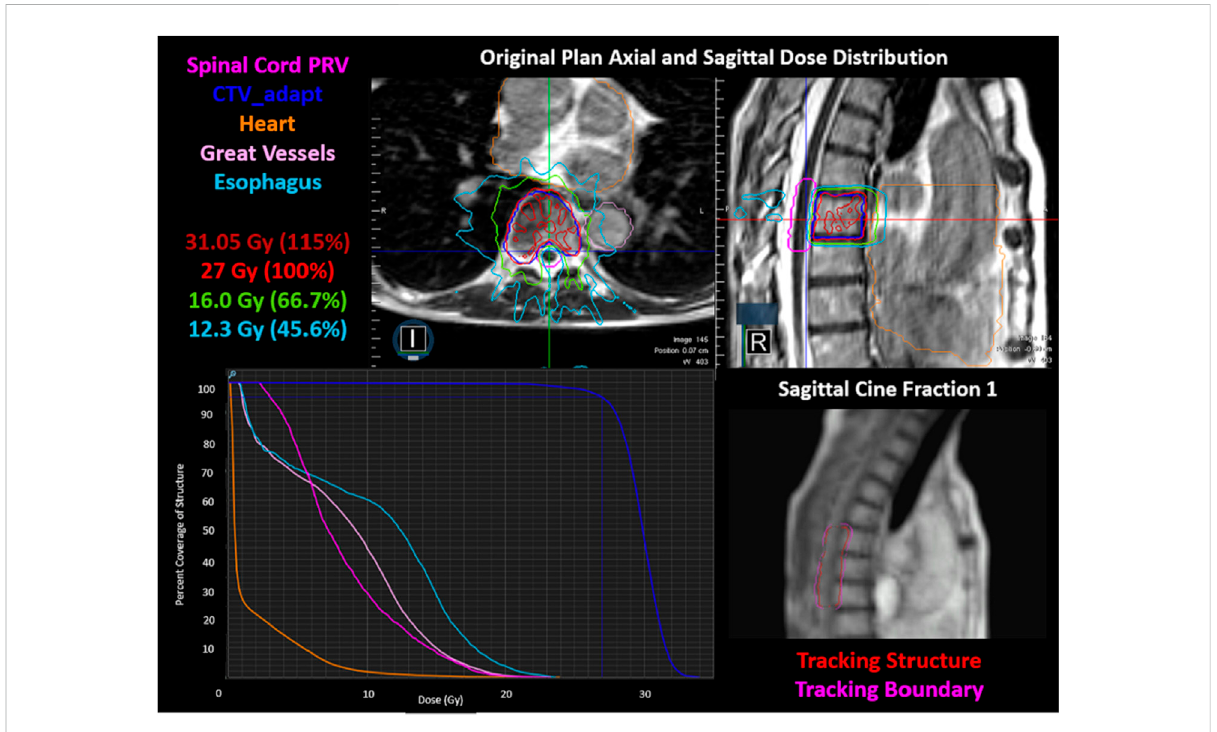
FIGURE 5 The original plan axial and sagittal dose distributions, showing the isodose lines, target structure, and organs at risk. The corresponding DVH is showninthebottomleft.Thecineimagequalityforfractiononeisshowninthebottomright,includingthetrackingstructureinredandthetracking boundary in pink.